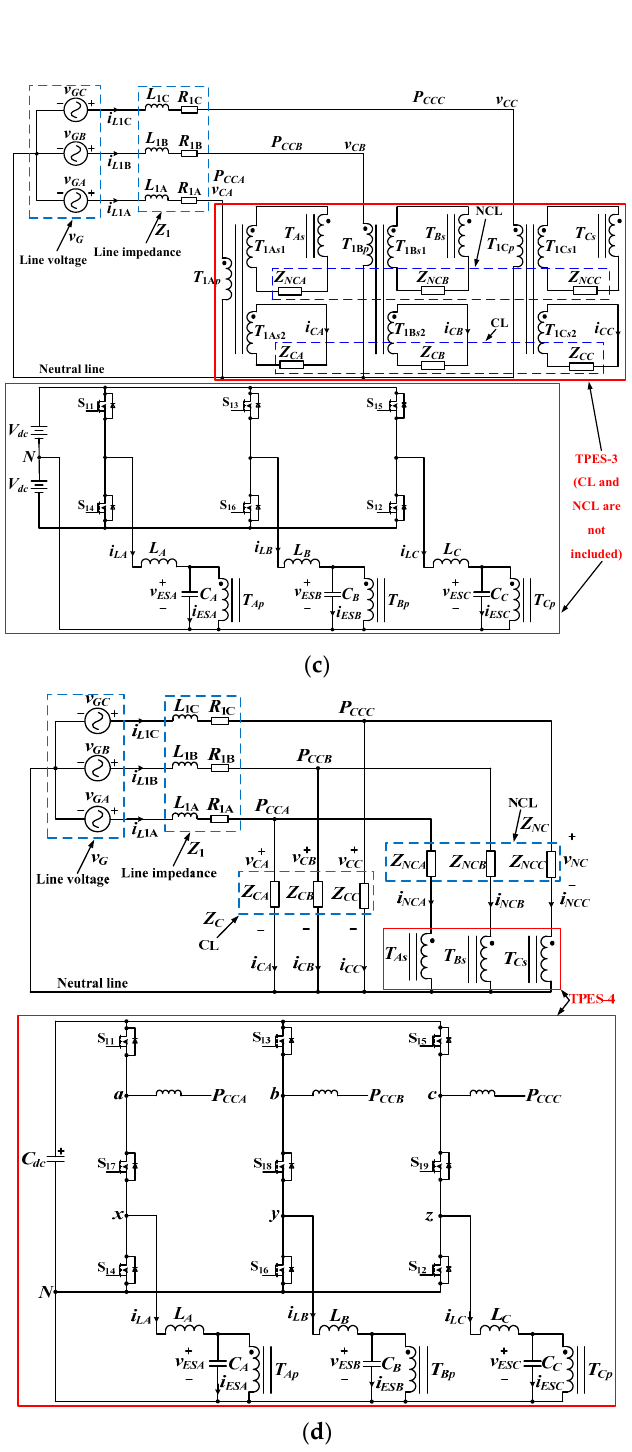
Figure 8. Topologies and typical application circuits of TPES-1, TPES-2, TPES-3 and TPES-4. ( a ) TPES-1; ( b ) TPES-2; ( c ) TPES-3; ( d ) TPES-4.